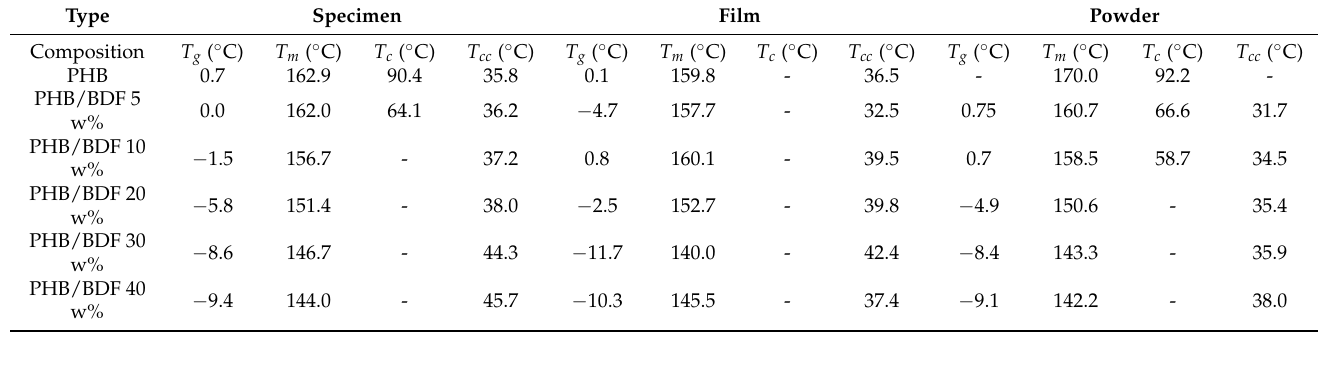
Table 1. DSC Analysis of the PHB/BDF Blends.